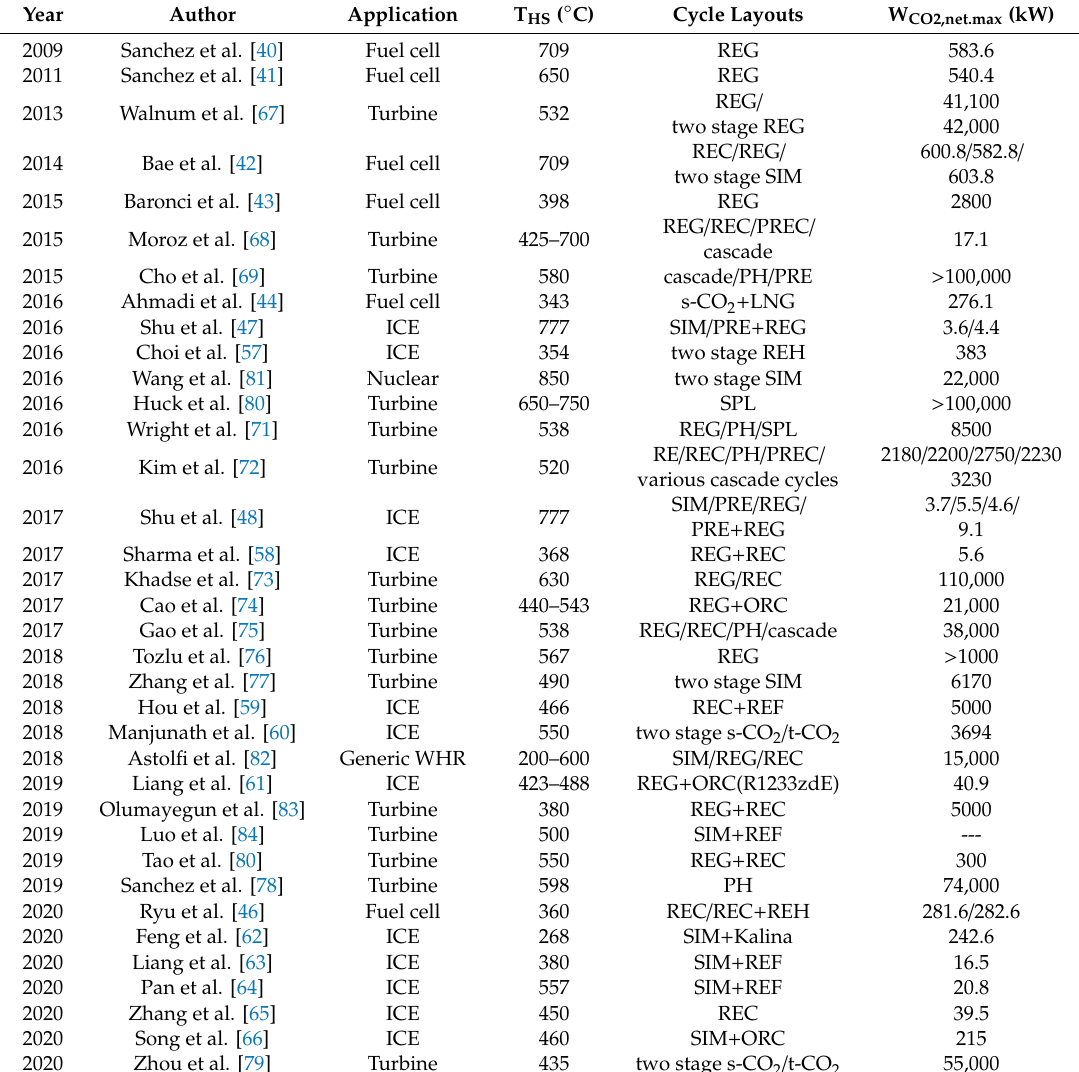
Table 1. Most relevantstudiesin chronological